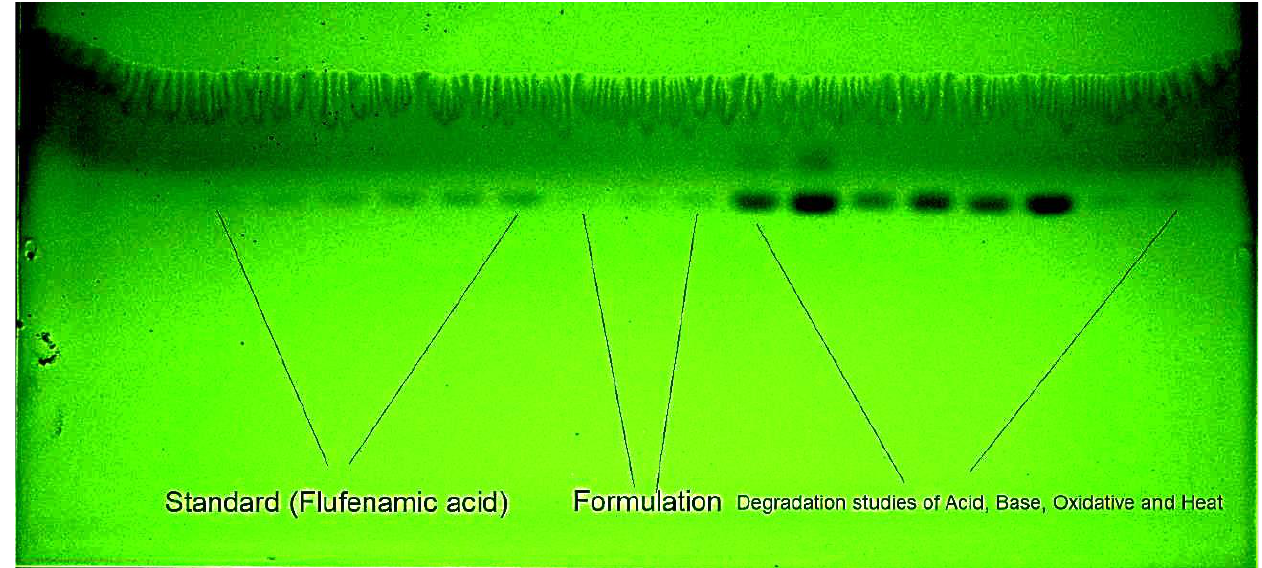
Figure 2. A representative thin-layer chromatographic (TLC) chromo-plate of standard FFA, marketed products, and forced degradation studies samples obtained using ecofriendly ethanol–water (70:30 v / v ) eluent system for the ecofriendly high-performance-TLC (HPTLC)